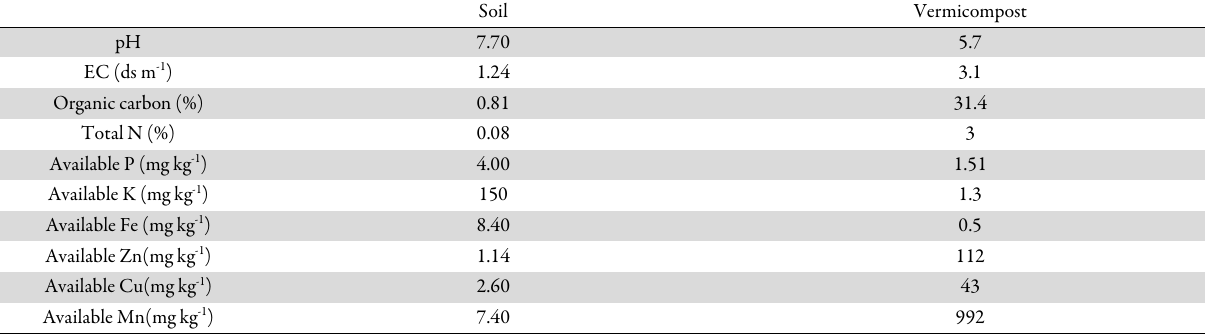
Table 1. General properties of top soil (0-30) and organic fertilizer (vermicompost)